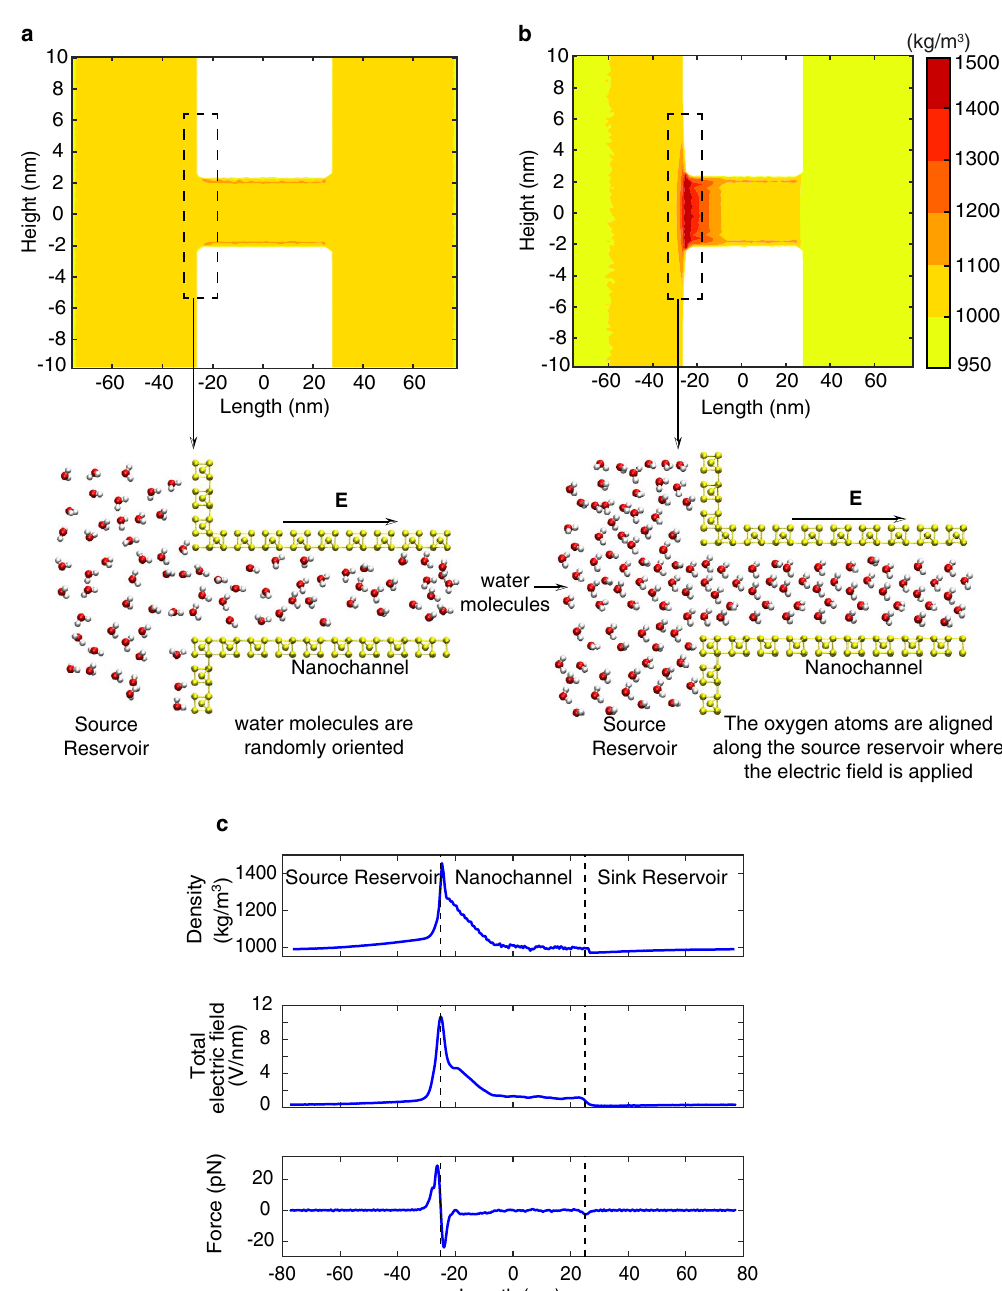
Figure 4. ( a, b ) shows the density distribution of the water molecules corresponding to the applied voltage of 30V and 170 V. Further, it shows the corresponding snapshots of the all-atom MD simulations. For clear visualizations, we showed one layer of water molecules. ( c ) shows a comparison of 1D distribution of water density, total electric field and dielectrophoretic force acting on the water molecules for the applied voltage of 170V. Drawings in ( a , b ) were created using VMD software (www. ks. uiuc. edu/ Devel opment/ Downl oad/ downl oad. cgi? Packa geName= VMD and version